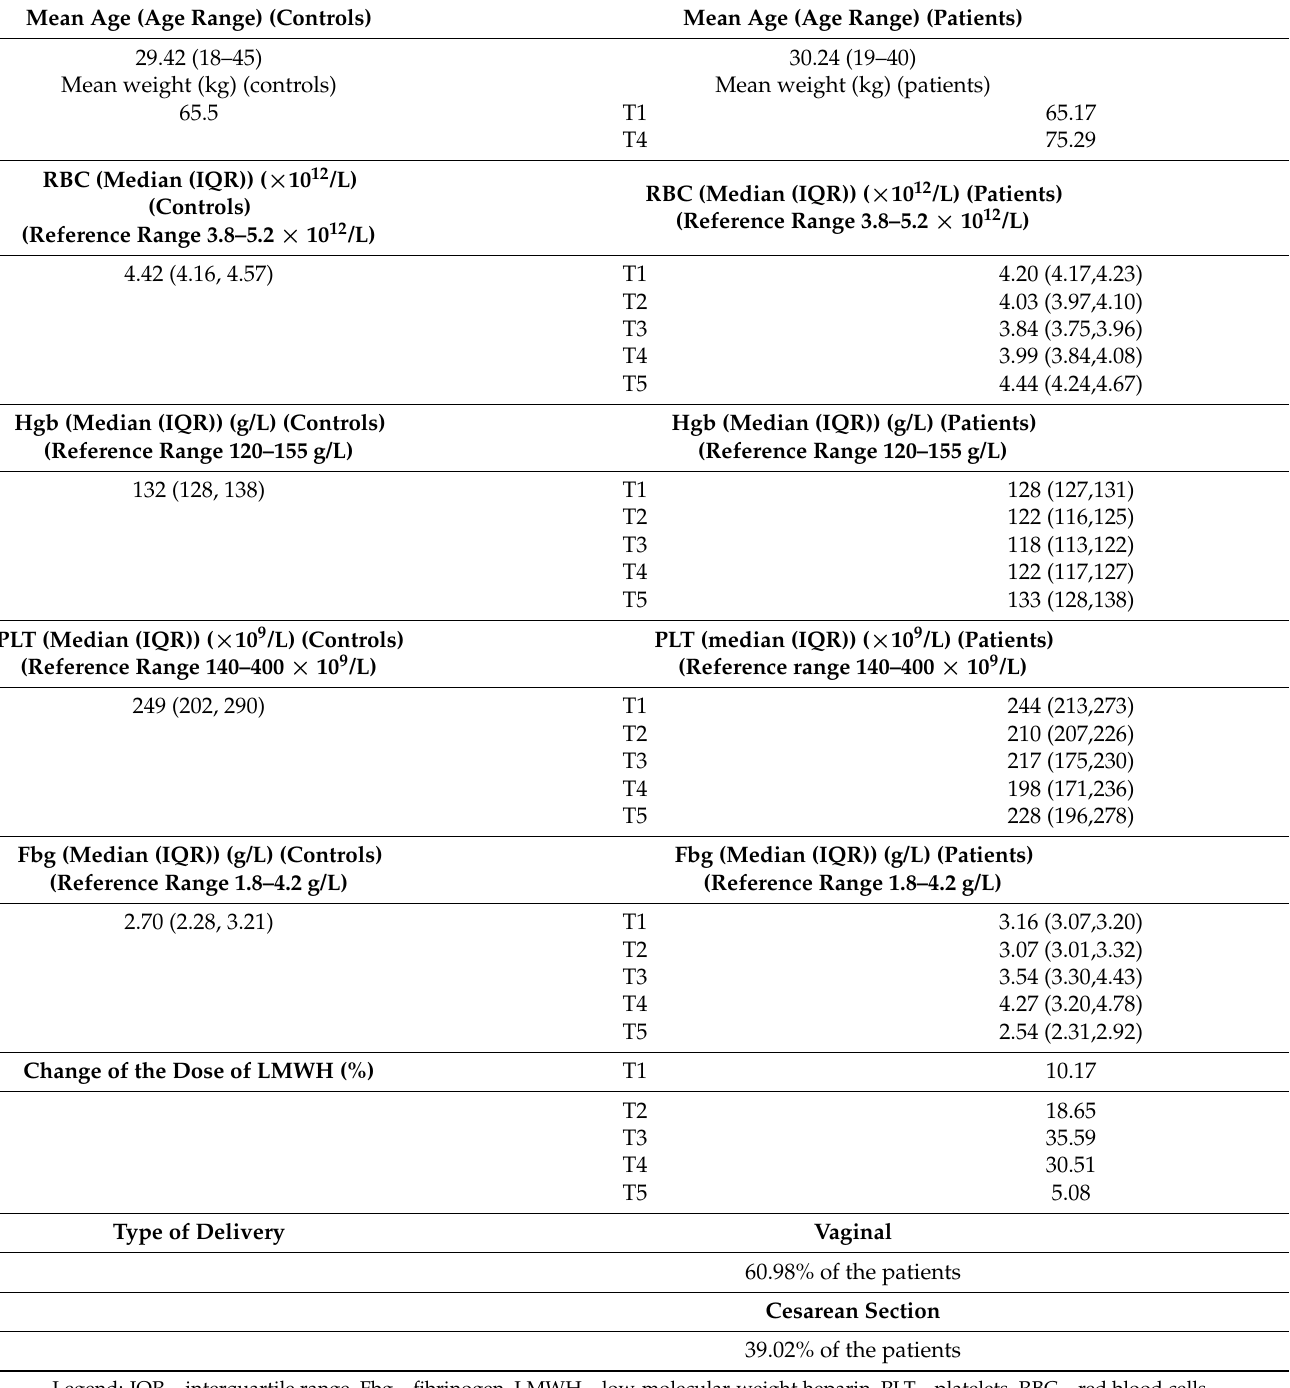
Table 2. Characteristics of pregnant patients and controls included in the